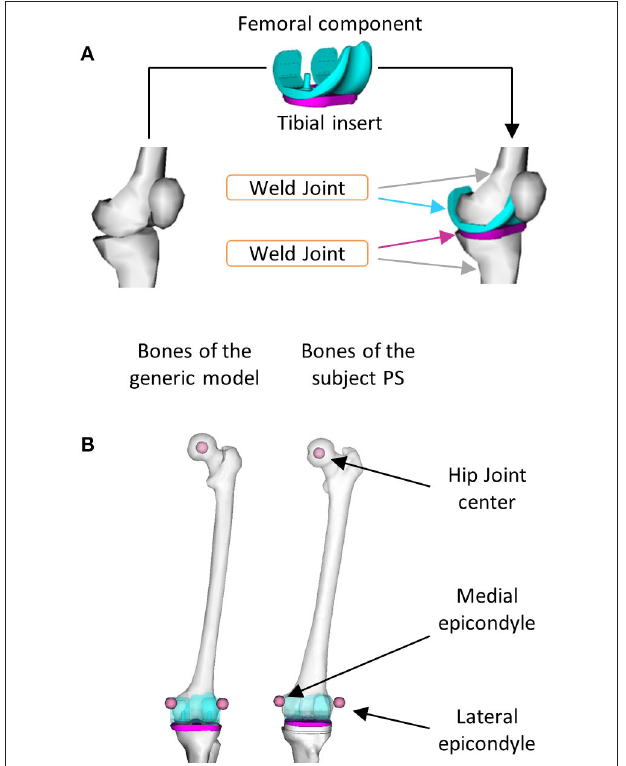
FIGURE 2 | Procedures used to include the implant components in the model: (A) Two welding joints were defined to connect the femoral component to the left femur and the tibial insert to the left tibia and (B) Bony landmarks were identified in the left femur of the generic model and in the one of the subject